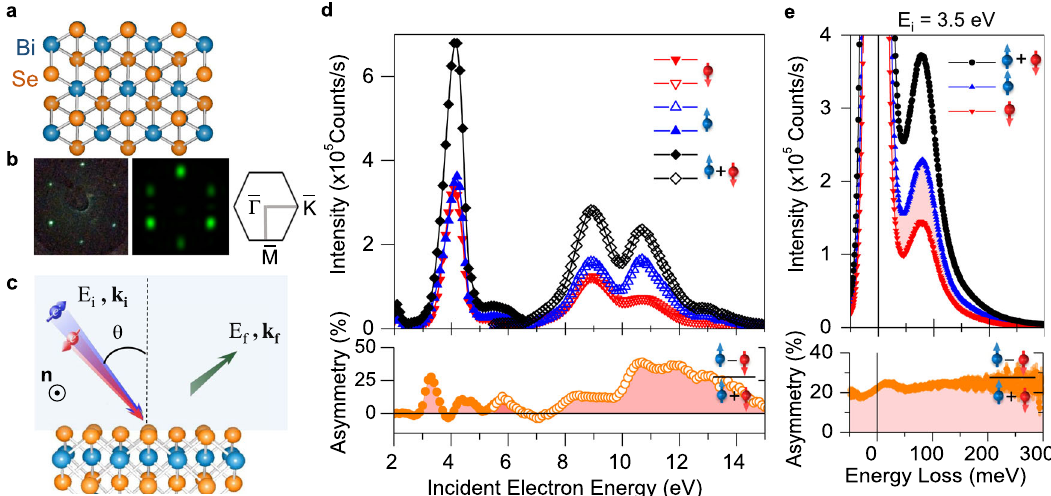
Fig. 1 Surface structure, spin-dependent elastic and inelastic scattering on Bi 2 Se 3 (0001). a The atomic structure of the Bi 2 Se 3 (0001) surface and b its corresponding low-energy electron diffraction (LEED) pattern, recorded at an electron energy of 78 eV. The experimental (left) and simulated (middle) LEED patterns are shown together with a schematic drawing of the surface Brillouin zone (right). c The scattering geometry. θ denotes the scattering angle. The red and blue arrows represent the spin of the incoming beam parallel and antiparallel to the scattering plane ’ s normal vector n . The scattering plane is shown by the shaded light-blue area. E i ( E f ) and k i ( k f ) denote the energy and the momentum of the incident (scattered) electron beam, respectively. d Intensity of the elastically scattered electron beam as a function of the incident beam energy. Data shown by fi lled and open symbols were recorded when the beam was optimized at 4 and 9 eV, respectively. e Spin-polarized electron energy-loss spectra recorded at a beam energy of 3.5 eV and at a momentum transfer of q = 0.05 Å − 1 . In d , e , the incident angle, i.e. the angle between the incident beam and the surface normal, was set to θ = 40°. The scattering plane was parallel to the high symmetry direction (cid:1) Γ – (cid:1) M of the surface Brillouin zone. ↓ and ↑ represent the spectra when the spin polarization of the incoming electron beam was parallel ( ↓ ) and antiparallel ( ↑ ) to the scattering plane ’ s normal vector n . The upper panels show the spin polarized and the total ( I ↓ + I ↑ ) spectra. The lower panels show the asymmetry A ¼ I # (cid:2) I " I spectra. The error bars represent the statistical uncertainties. The strong noise (or # þ I " large error bars) in the asymmetry spectra for the loss energies >200 meV is due to the fact that the total intensity decreases substantially. The total intensity appears in the denominator of spin asymmetry. Hence, the larger uncertainties in the total intensity lead to larger errors in the